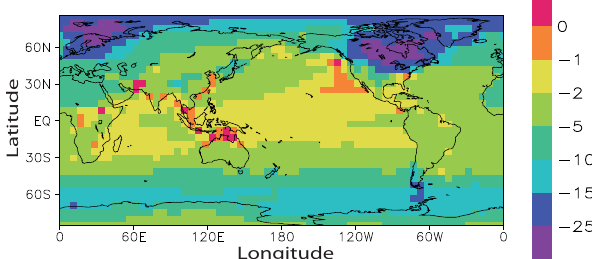
Fig. 21. Simulated difference of annual mean surface temperatures (in °C) between the last glacial maximum and present-day conditions.